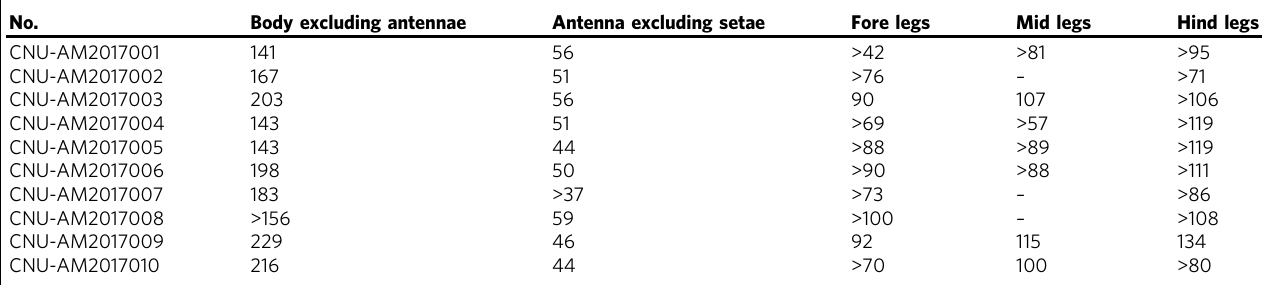
Table 1 Dimensions of all ten specimens from mid-Cretaceous ( µ